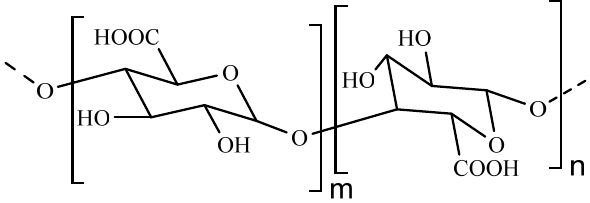
Figure 5. The structure of alginate.